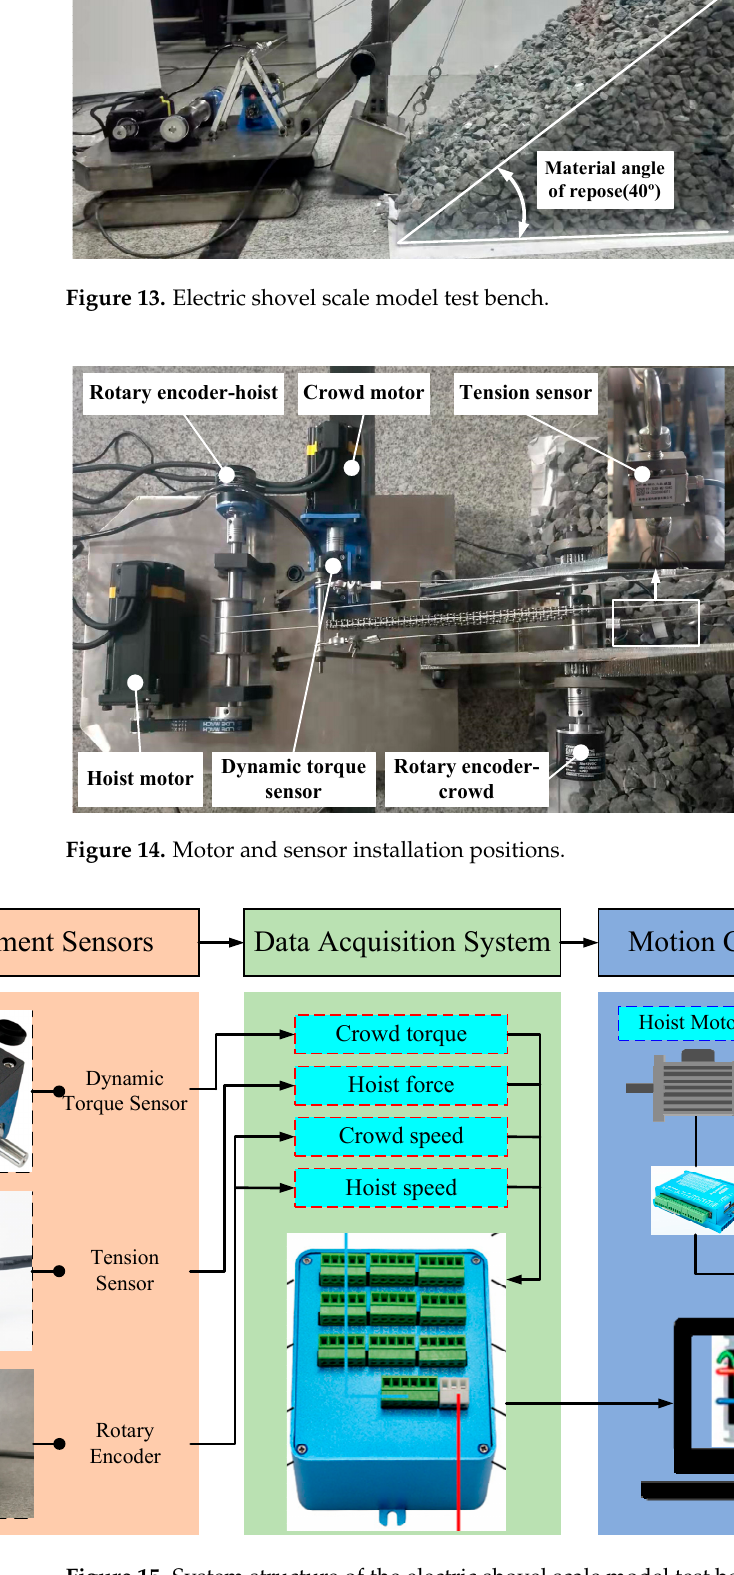
Figure 15. System structure of the electric shovel scale model test bench.